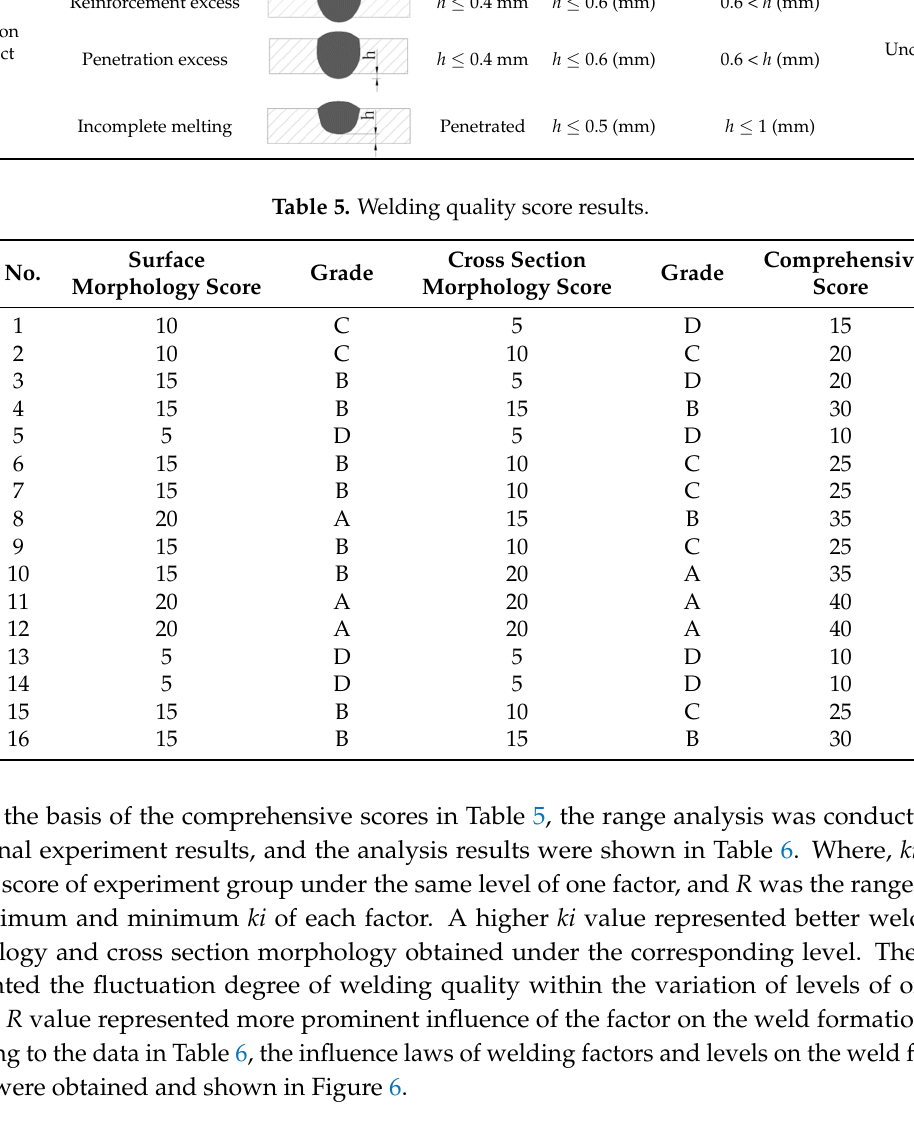
Table 6. Range analysis of welding quality